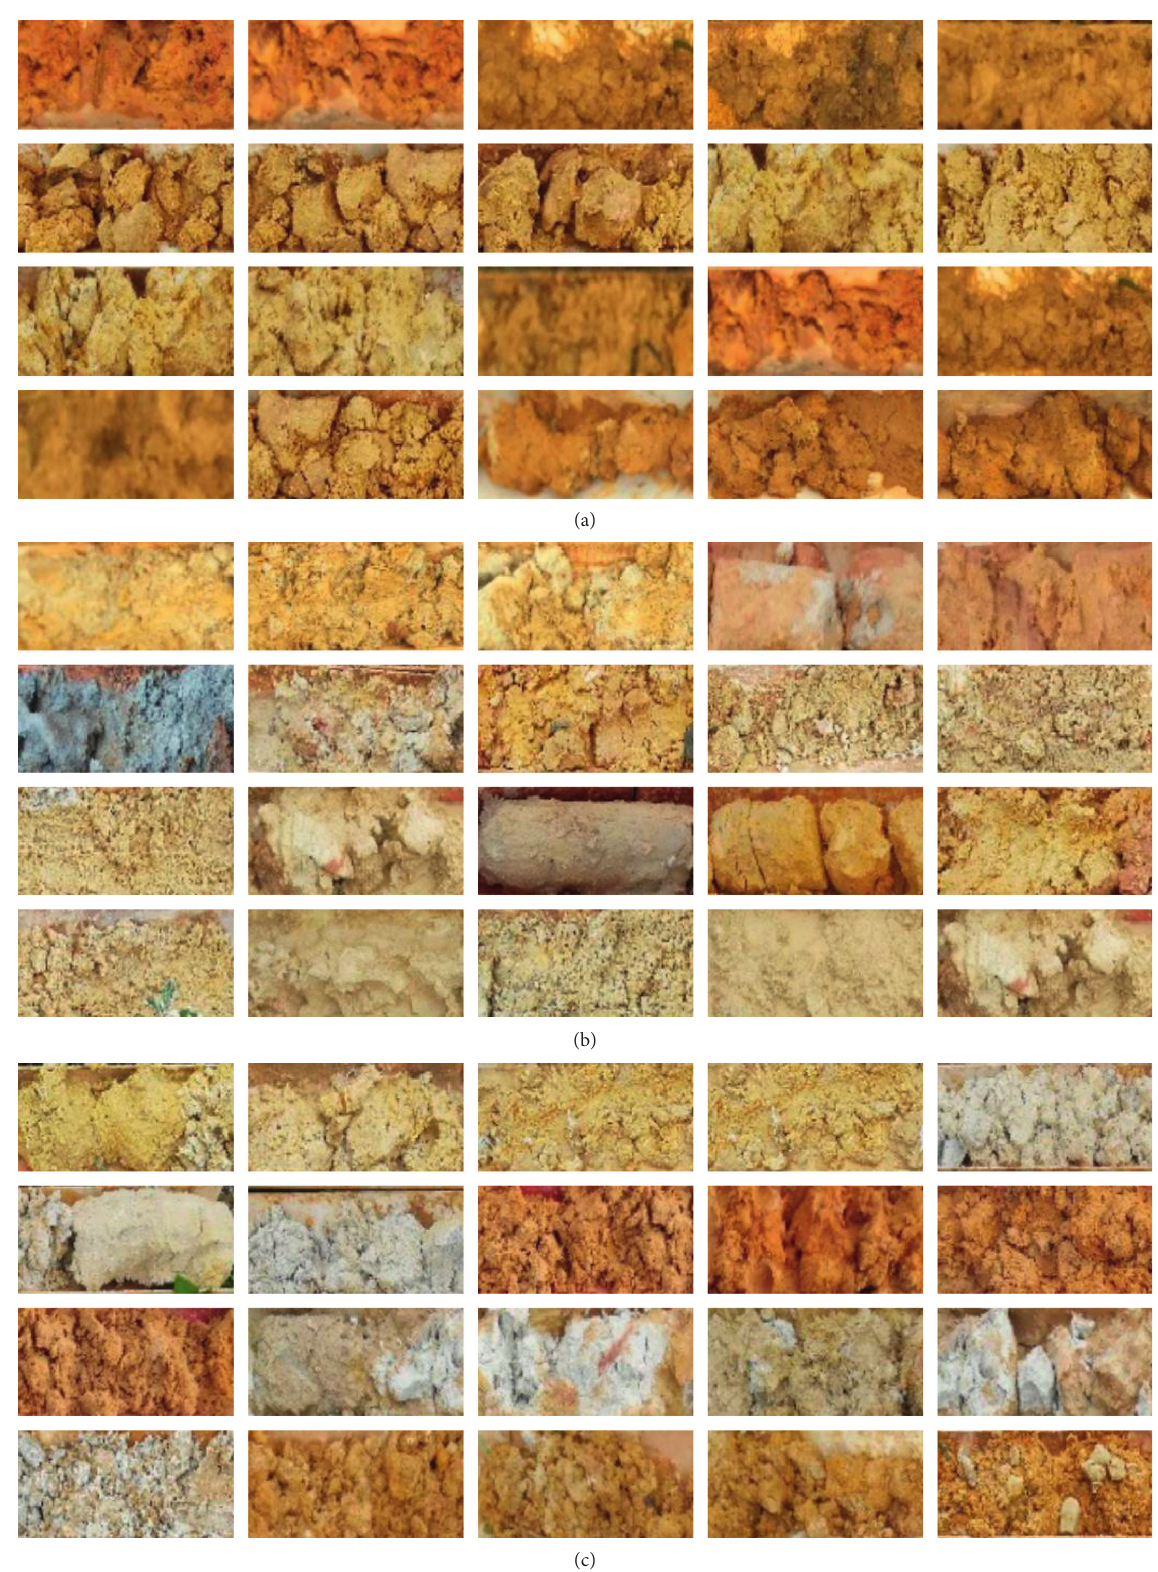
Figure 5: Sand core sample analysis data sample. (a) Loose sand image. (b) Slightly dense sand image. (c) Medium dense sand